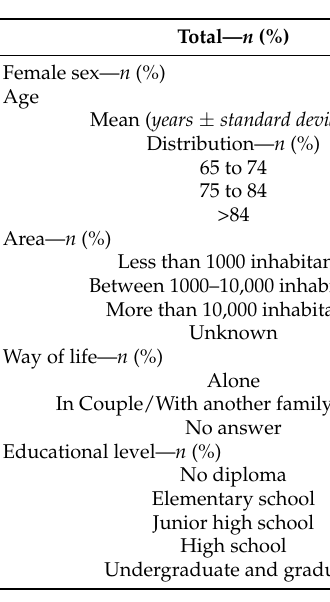
Table 1. Respondents’